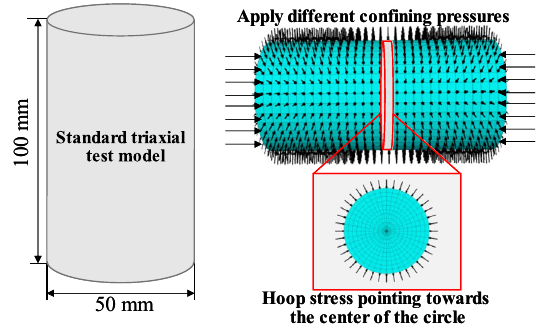
Fig. 12 Model of FLAC 3D triaxial